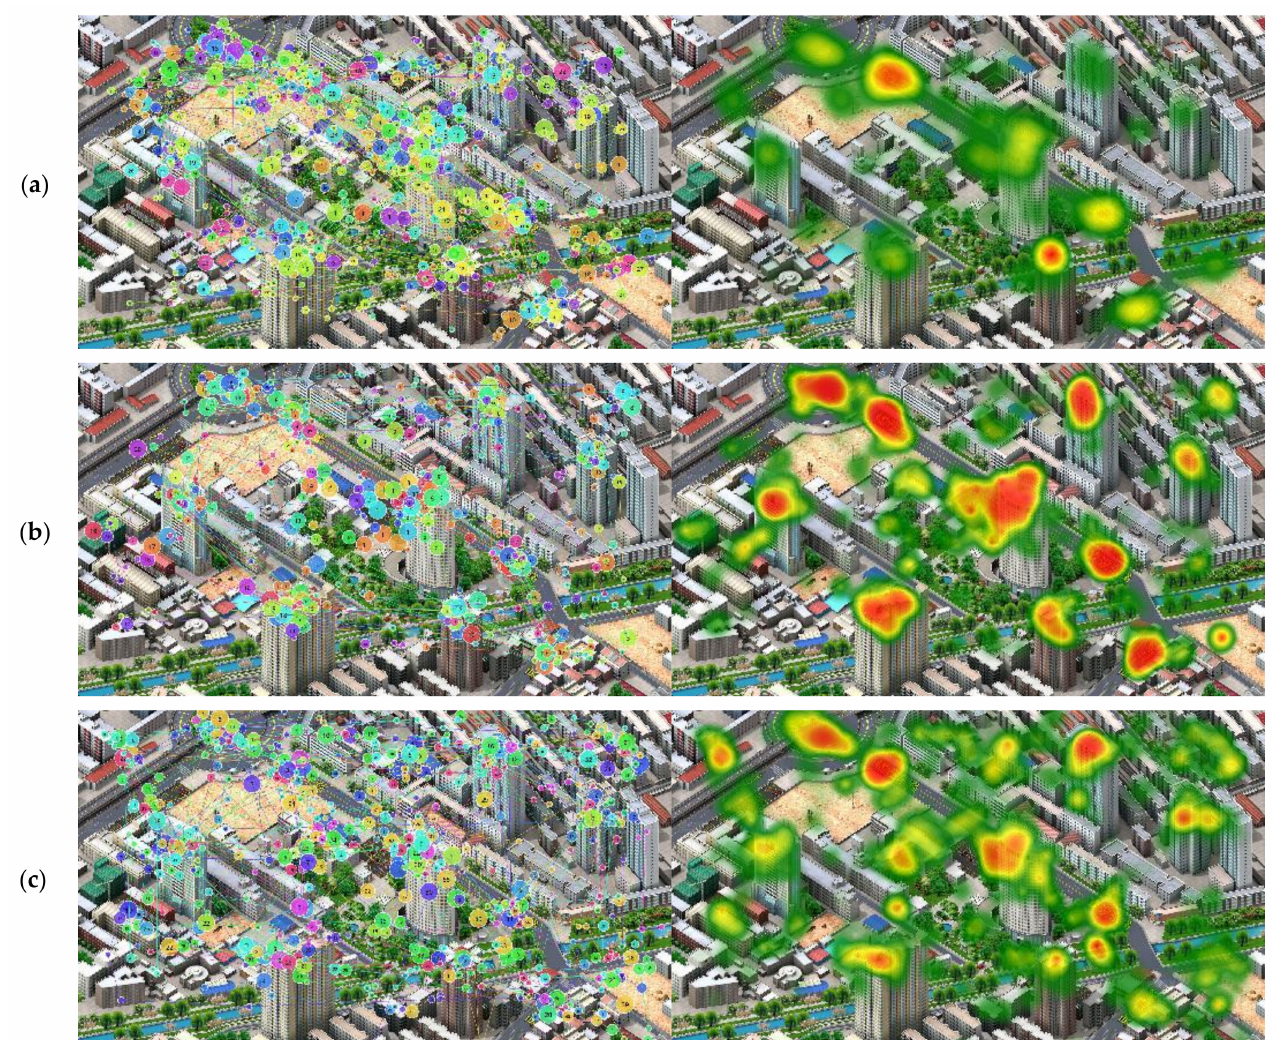
Figure 4. The figure shows the track maps and heat maps shown by “active browsing” ( a ), “timed browsing” ( b ), and “passive browsing” ( c ). The heat map shows the different distributions of the participants’ fixation, and the darker the color, the longer the fixation time. The track map shows the movement of the participants’ fixation track, the circle represents the location of the fixation point, and the numbers inside represent the order of